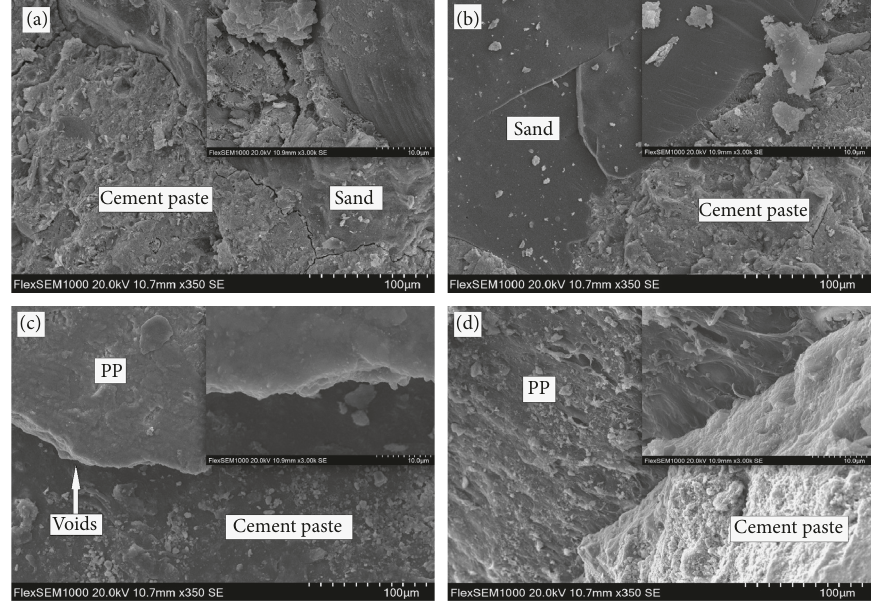
Figure 11: SEM pictures of the mortar specimens at day 28. (a) PP0, (b) PN0, (c) PP6, and (d)